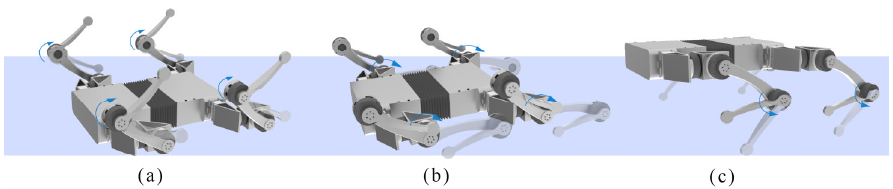
Figure 11. Sideways: turning over after capsizing: ( a ) Actuator 4 drives the calf to approach the thigh; ( b ) Actuator 3 drives the thigh and calf to approach the ground; ( c ) Actuators 3 and 4 work together to drive the thigh and calf to slowly support the whole robot.